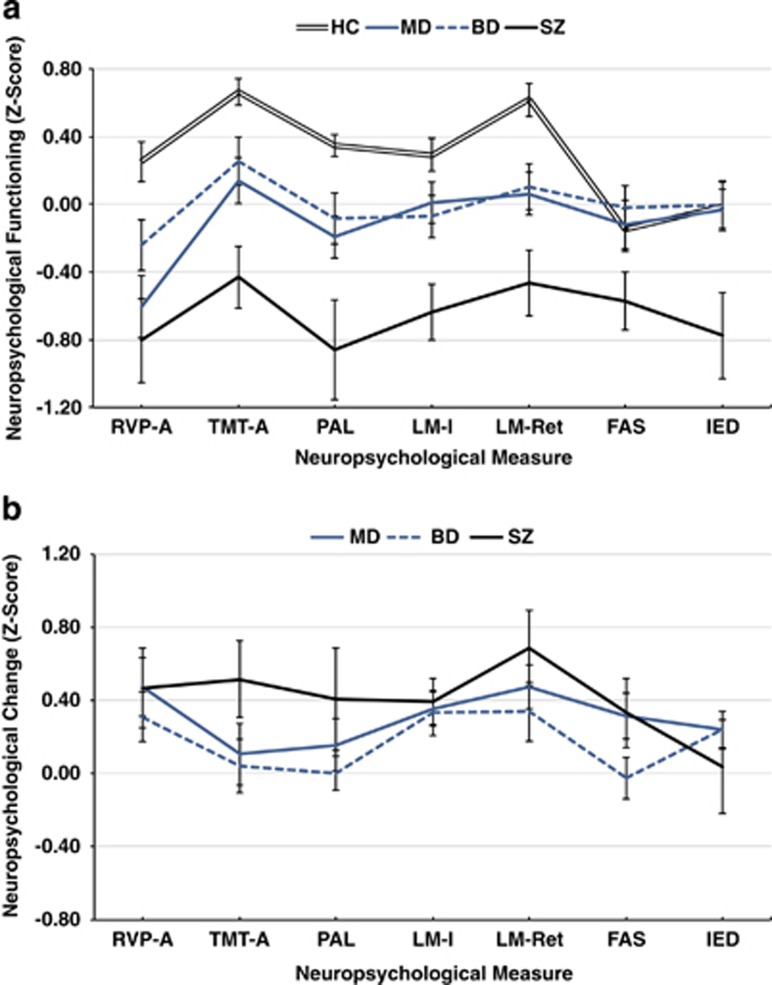
Mean standardized neuropsychological performance (±s.e.) at baseline (a) and mean standardized neuropsychological change (±s.e.) at follow-up (b) by diagnosis. At baseline (a), neuropsychological functioning was significantly different between diagnoses across all measures (except FAS). Specifically, patients with schizophrenia-spectrum disorder (SZ) performed worse than healthy controls (HCs; P<0.05) on all measures (except FAS). Major depression (MD) and bipolar disorder (BD) each performed worse than HC (P<0.05) on RVP-A, PAL and LM-Ret. Separately, MD and BD performed worse than HC (P<0.05) on TMT-A and LM-I, respectively. MD and BD each outperformed SZ on TMT-A, PAL, LM-I, LM-Ret and IED (P<0.05). MD and BD did not differ from each other on any measure (P>0.05). At follow-up (b), LM-Ret was the only measure improving significantly over time across diagnoses (P<0.05). All group × time interactions were nonsignificant (P>0.05). FAS, Controlled Oral Word Association Test; IED, Intra-/Extradimensional shift test-total errors; LM-I, Logical Memory I; LM-Ret, Logical Memory II Percent Retention; PAL, Paired Associates Learning-adjusted errors; RVP-A, Rapid Visual Processing Hits A′ TMT-A′, Trail Making Test—Part A.